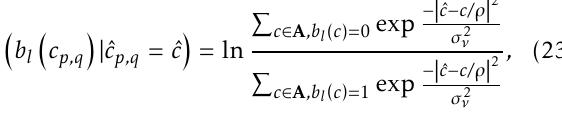
Figure 5. BER as a functionof E b /N 0 , with ρ = 16 / 15 . exclusive, probability for the l th bit of a symbol c p,q